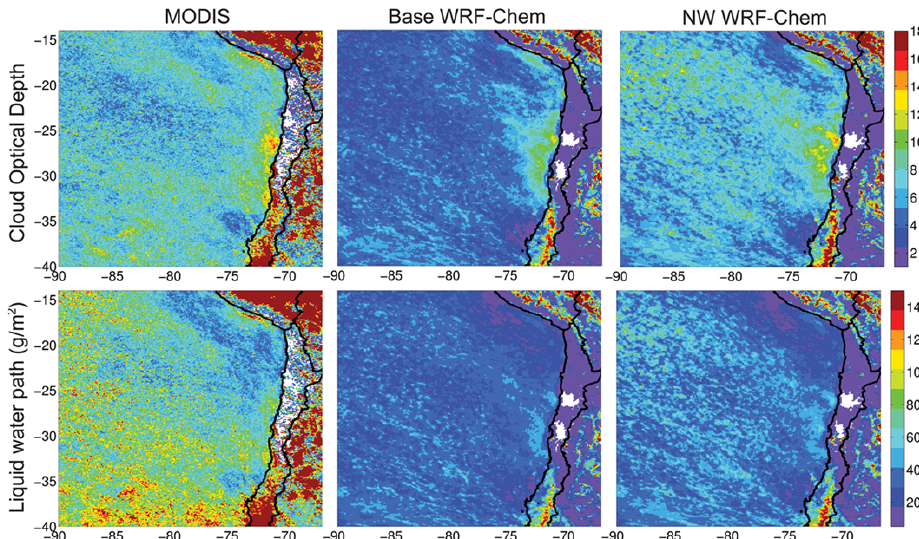
Fig. 7. MODIS-Aqua products and model monthly averages for the VOCALS period (15 October to 16 November). First and second row show cloud optical depth (COD) and liquid water path (LWP), respectively while first, second and third columns show MODIS, the base model and the no wet deposition (NW) model,